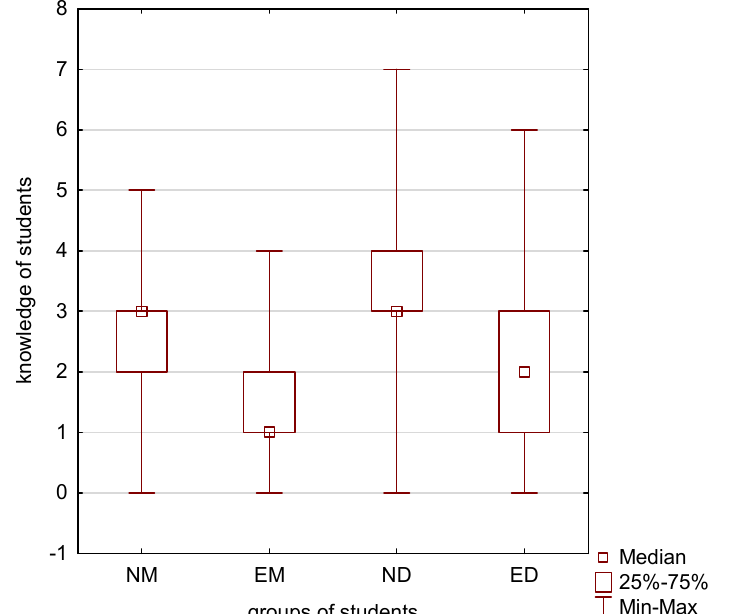
Figure 1. Comparison of total knowledge between NM, ND, EM and ED students (Kruskal—Wallis test, p < 0.001).